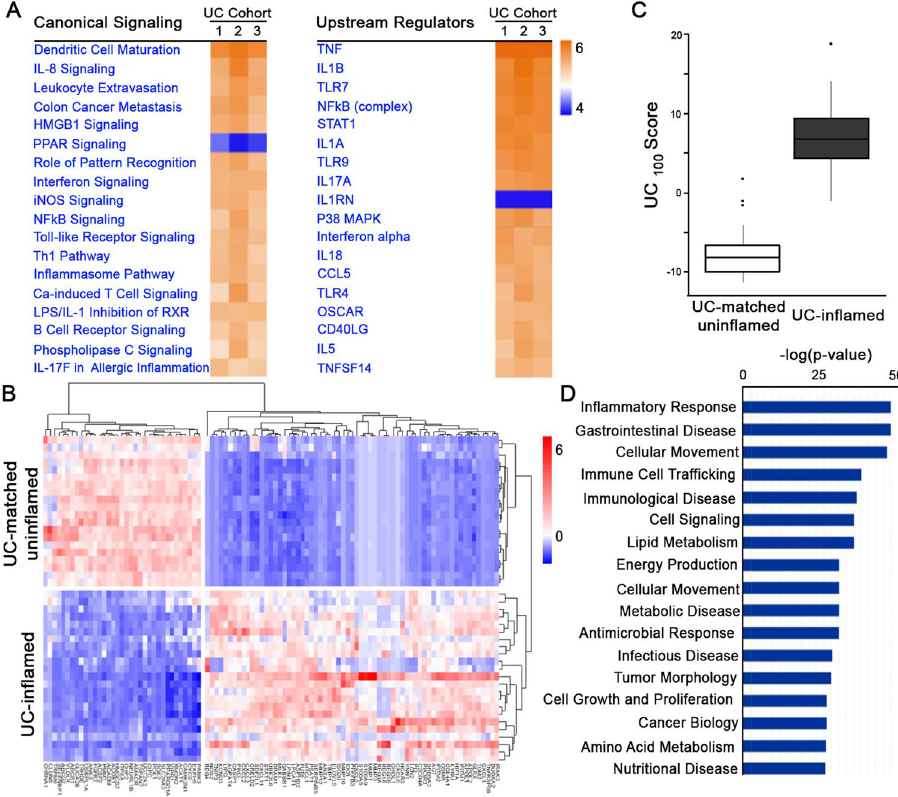
Figure 2. Altered molecular pathways in inflamed UC tissue. ( A ) IPA canonical pathway and upstream regulator analysis revealed similarly enriched pathways across three independent cohorts (1: GSE4183, n = 8 healthy control, n = 9 UC-inflamed; 2: GSE14580, n = 6 healthy control, n = 24 UC-inflamed; 3: GSE38713, n = 13 healthy control, n = 15 UC-inflamed; IPA, FDR < 0.05). ( B ) Hierarchical clustering, as shown by representative heatmap, revealed two distinct clusters of UC samples separated by the UC 100 signature (generated from GSE4183, GSE14580, GSE38713) differentiating between inflamed UC and matched uninflamed transcriptomes from an independent cohort (GSE107593) (n = 24 UC-inflamed, n = 24 UC-matched uninflamed). ( C ) Presence of the UC 100 signature represented as a score in inflamed UC compared to uninflamed matched control transcriptomes from an independent cohort (GSE107593) ( p = 4.65e -08 ). ( D ) Disease and function enrichment analysis for UC 100 signature (IPA, p <